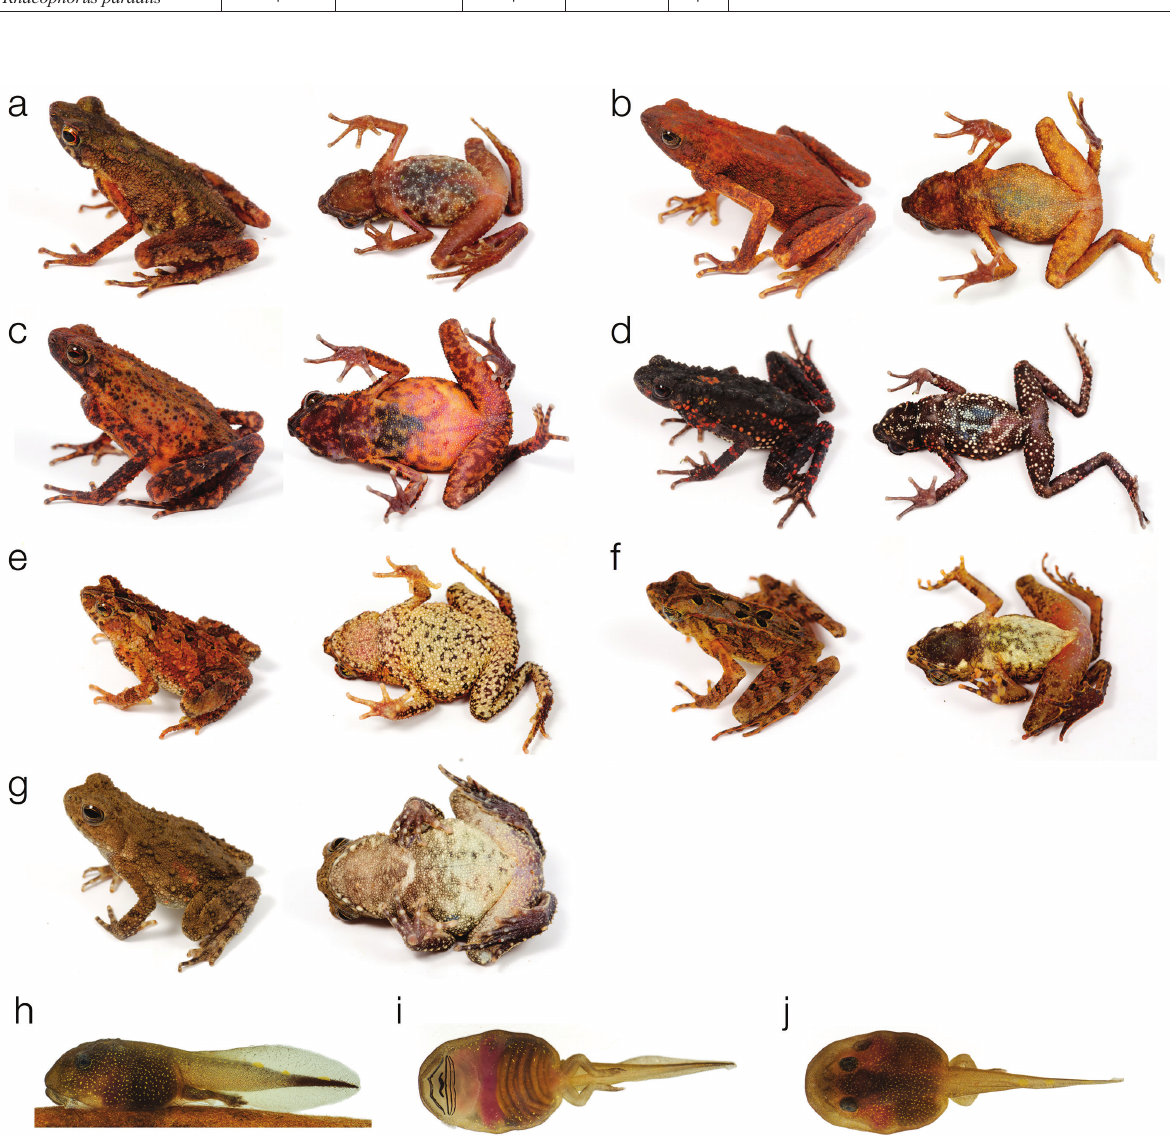
Figure 1. Frogs of the Bufonidae at MBCA: a Ansonia sp. ; b , Ansonia leptopus ; c , Ansonia longidigita ; d , Ansonia spinulifer ; e , Ingerophrynus divergens ; f , Leptophryne borbonica ; g , Phrynoidis juxtasper (juvenile); h–j , Phrynoidis juxtasper tadpole (lot ZMH A12578) in lateral, ventral, and dorsal views. Images not to scale. Pairs of photos (dorsolateral and ventral) depict the same